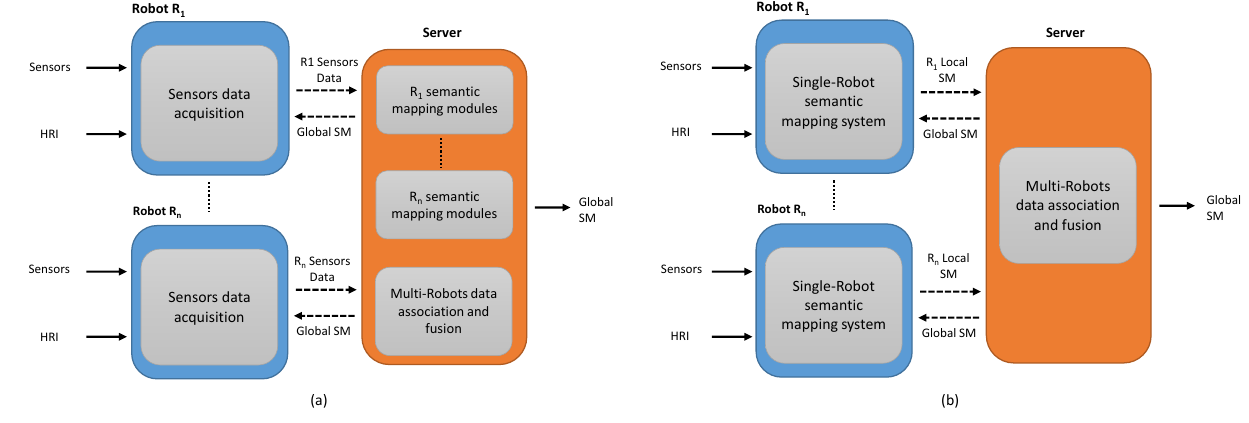
Figure 6. Representation of the distribution of a semantic-mapping system in a centralized architec- ture. ( a ) Robots play the role of sensors and the whole process of semantic mapping is performed in the server, ( b ) each robot implements a complete semantic-mapping system and the server manages the fusion and association of the multi-robot local